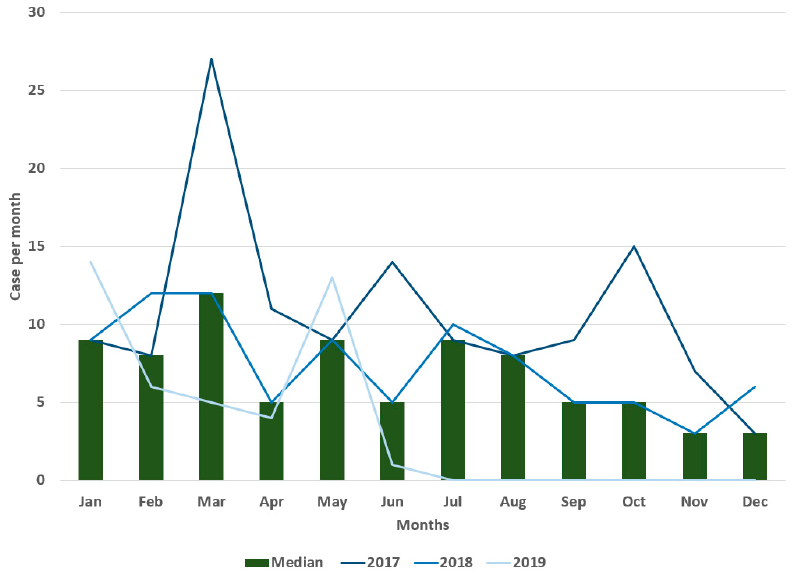
Figure 3. Number of cases and median by months from 2017 to 2019, bovine rabies, Colombia.